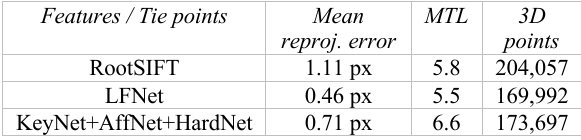
Table 4: AT results for the Dublin dataset.